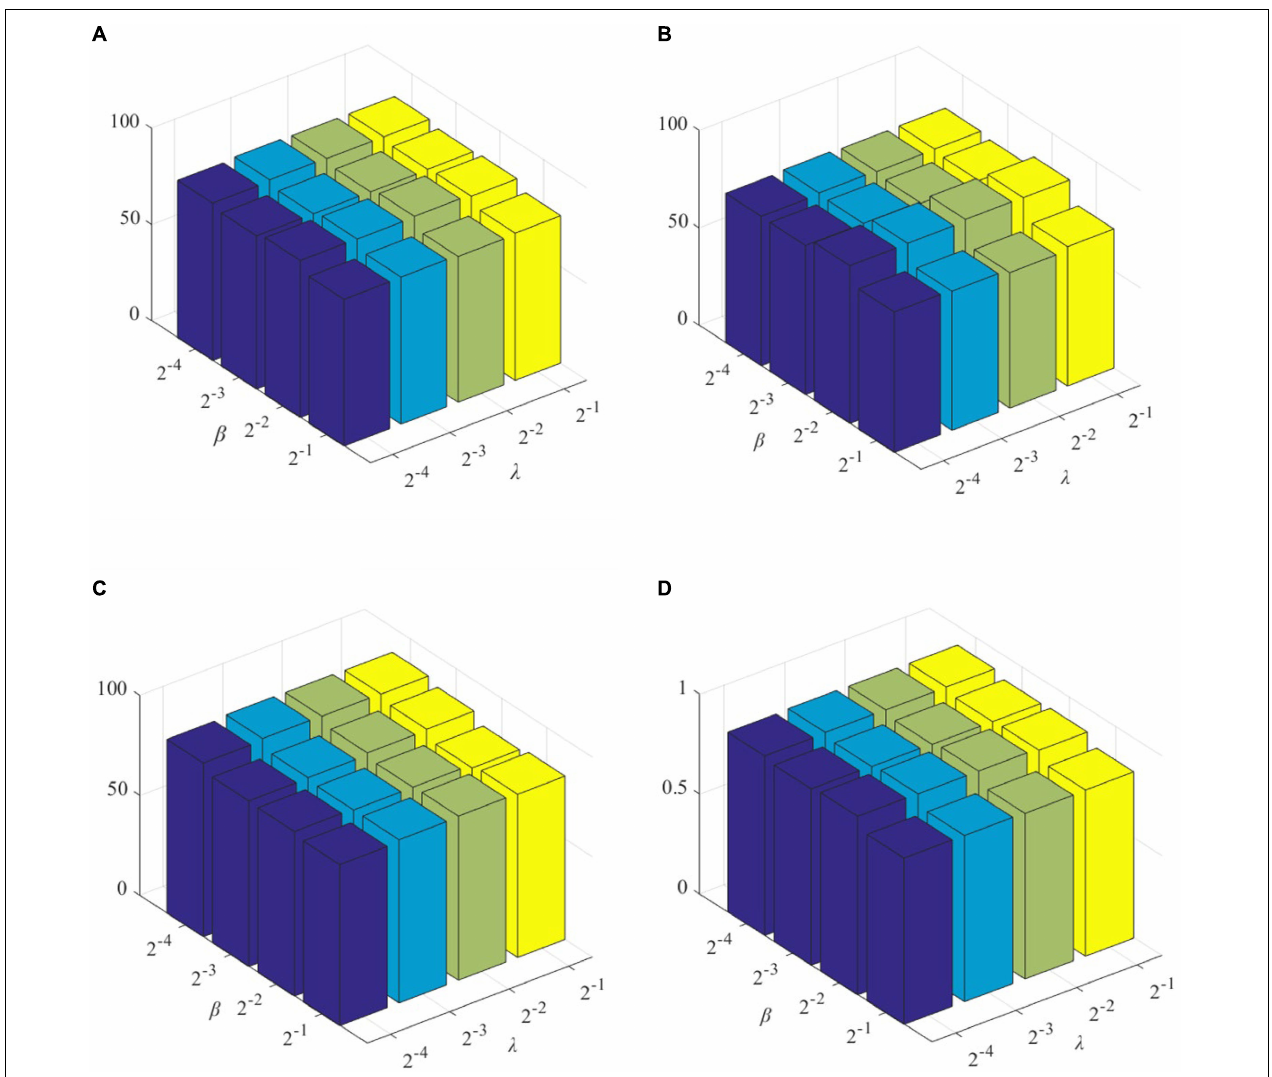
FIGURE 2 | Classification performance of SDBFNs obtained by different regularization parameters: (A) ACC, (B) SEN, (C) SPE, and (D) AUC.